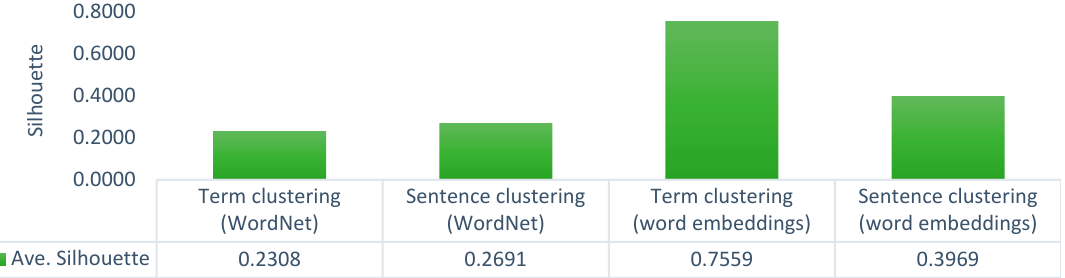
Figure 4. Averaged Silhouette values of compared topic detection approaches applied to the TelecomServ dataset.